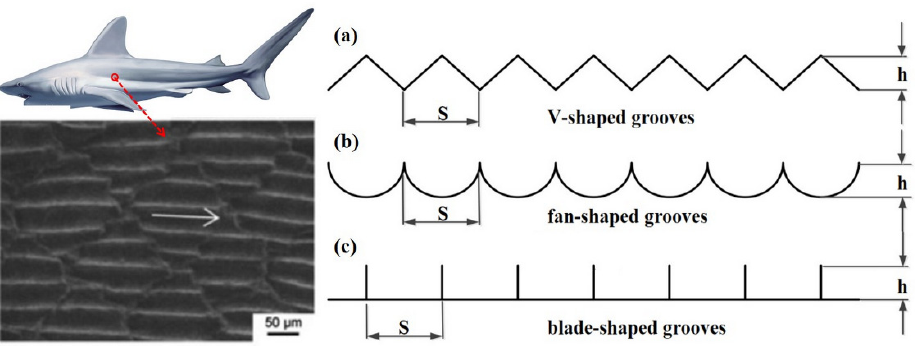
Figure 1. The microstructure of riblet on shark skin [5] and three kinds of micro-groove models. Due to their simple lateral interface structure, some typical two-dimensional groove surfaces, such as V-shaped grooves, fan-shaped grooves, and blade-shaped grooves are selected to thoroughly study surface microstructure models of their grooves in the flowing direction [10]. However, the drag reduction rate of these surface microstructure models is not very prominent. In order to improve the surface drag reduction rate, the effect of surface hydrophobicity is proposed. Neihuis et al. [17,18] studied the surface microstructures of 300 kinds of plants, found spherical crown structures and waxy substances of micro-scale exist on the rough surface of plants. The surface microstructure of plant surfaces shows obvious hydrophobicity. Watson et al. [19] studied the microstructure of termite and cicada wings, and found spherical crown-like protrusions are distributed on their wings.